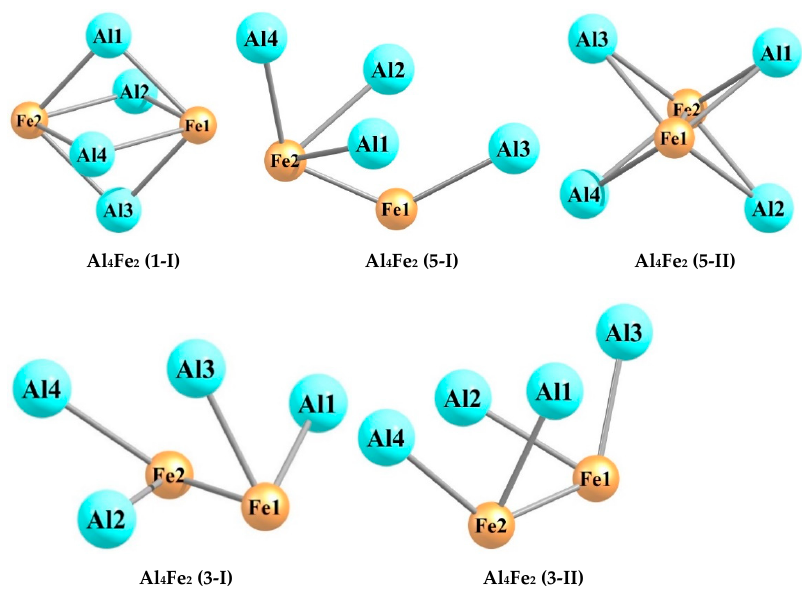
Figure 2. Molecular structures of the five most energetically stable Al 4 Fe 2 metal clusters.